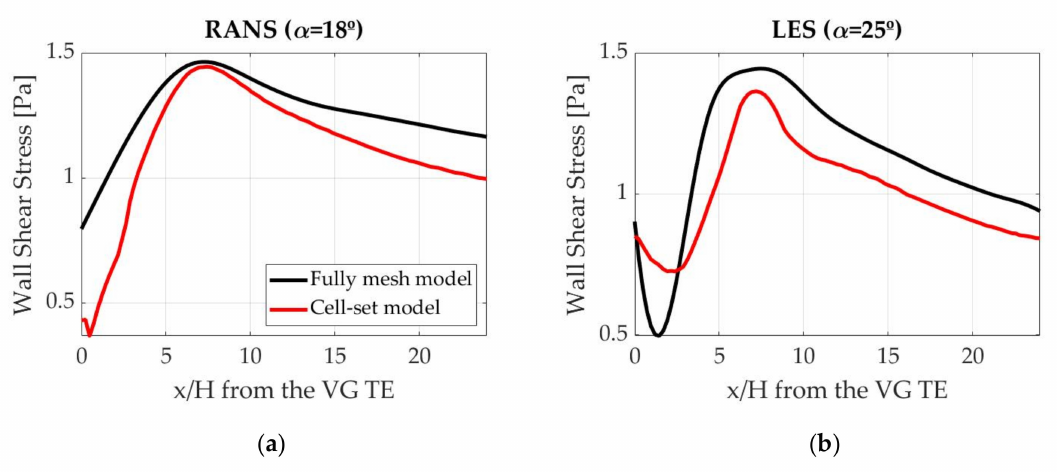
Figure 11. Wall shear stress behind the Trailing Edge (TE) of the VG: ( a ) RANS; ( b )